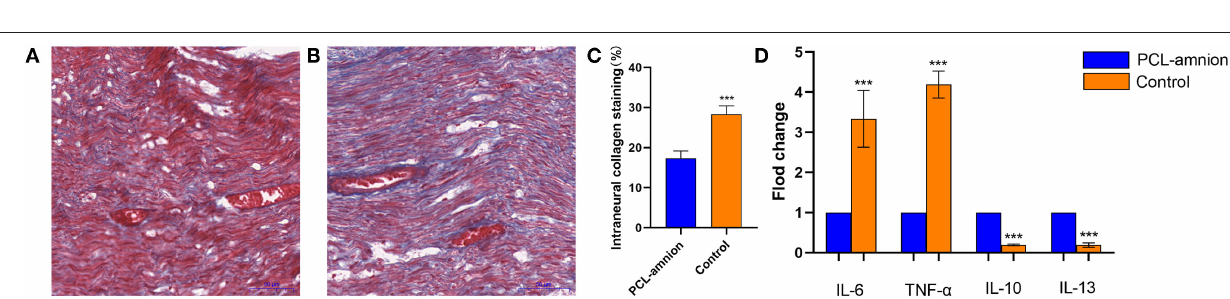
Control group. These results indicate that the PCL-amnion nanofibrous membrane regulates the proportion of M1/M2 macrophages, inhibiting inflammatory factors and enhancing